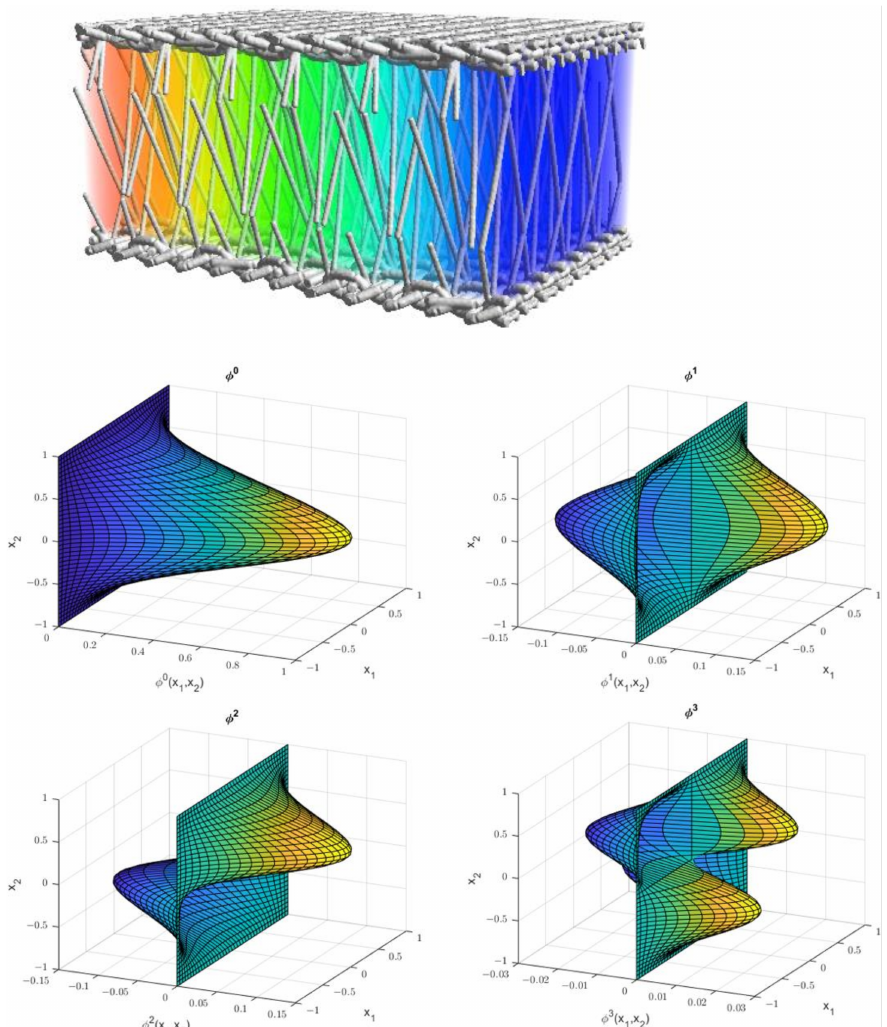
Figure 18. Test functions on the mean surface of monofilament forests for the finite element